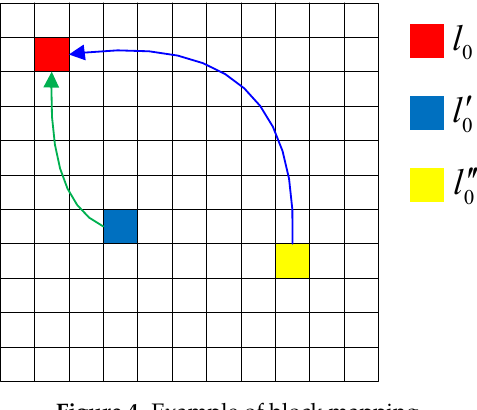
Figure 4. Example of block